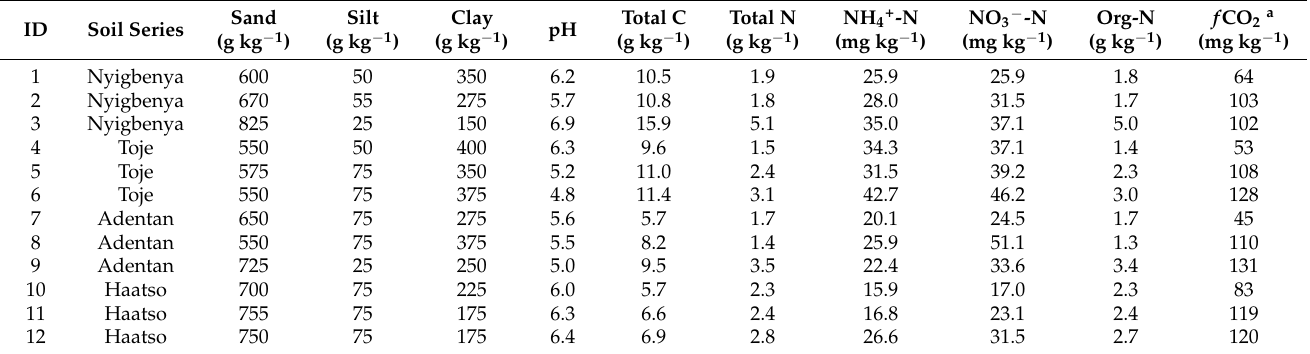
Table 1. Physical and chemical properties of the soils